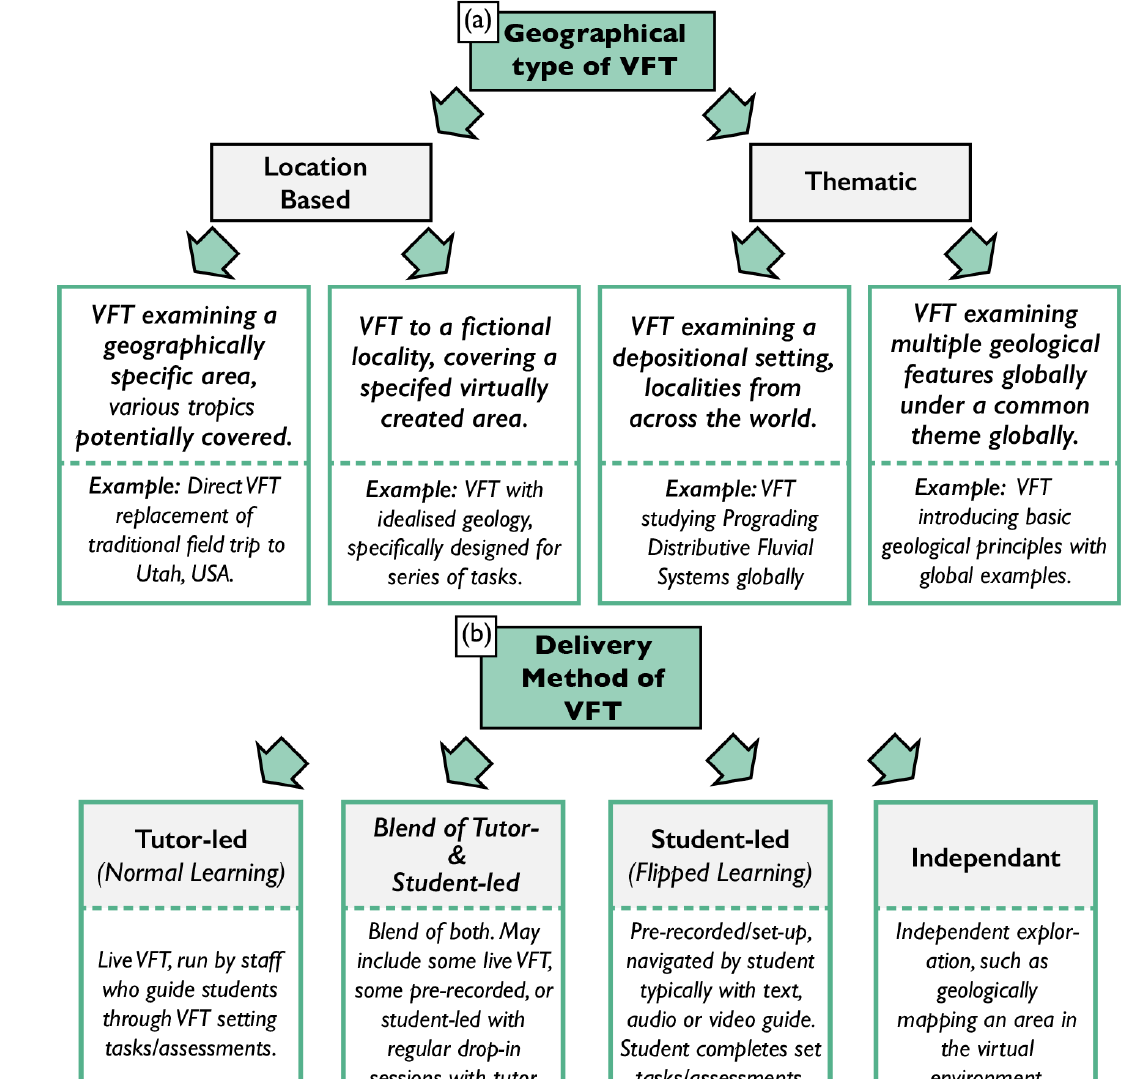
Figure 1. Outline of types and delivery methods of VFTs. (a) Types of VFT separated between location-based trips to a specific locality and thematic trips spanning global localities with a common theme. Examples are given. (b) Delivery method of VFT divided into tutor-led VFTs and student-led VFTs as well as the blended spectrum between. Examples are